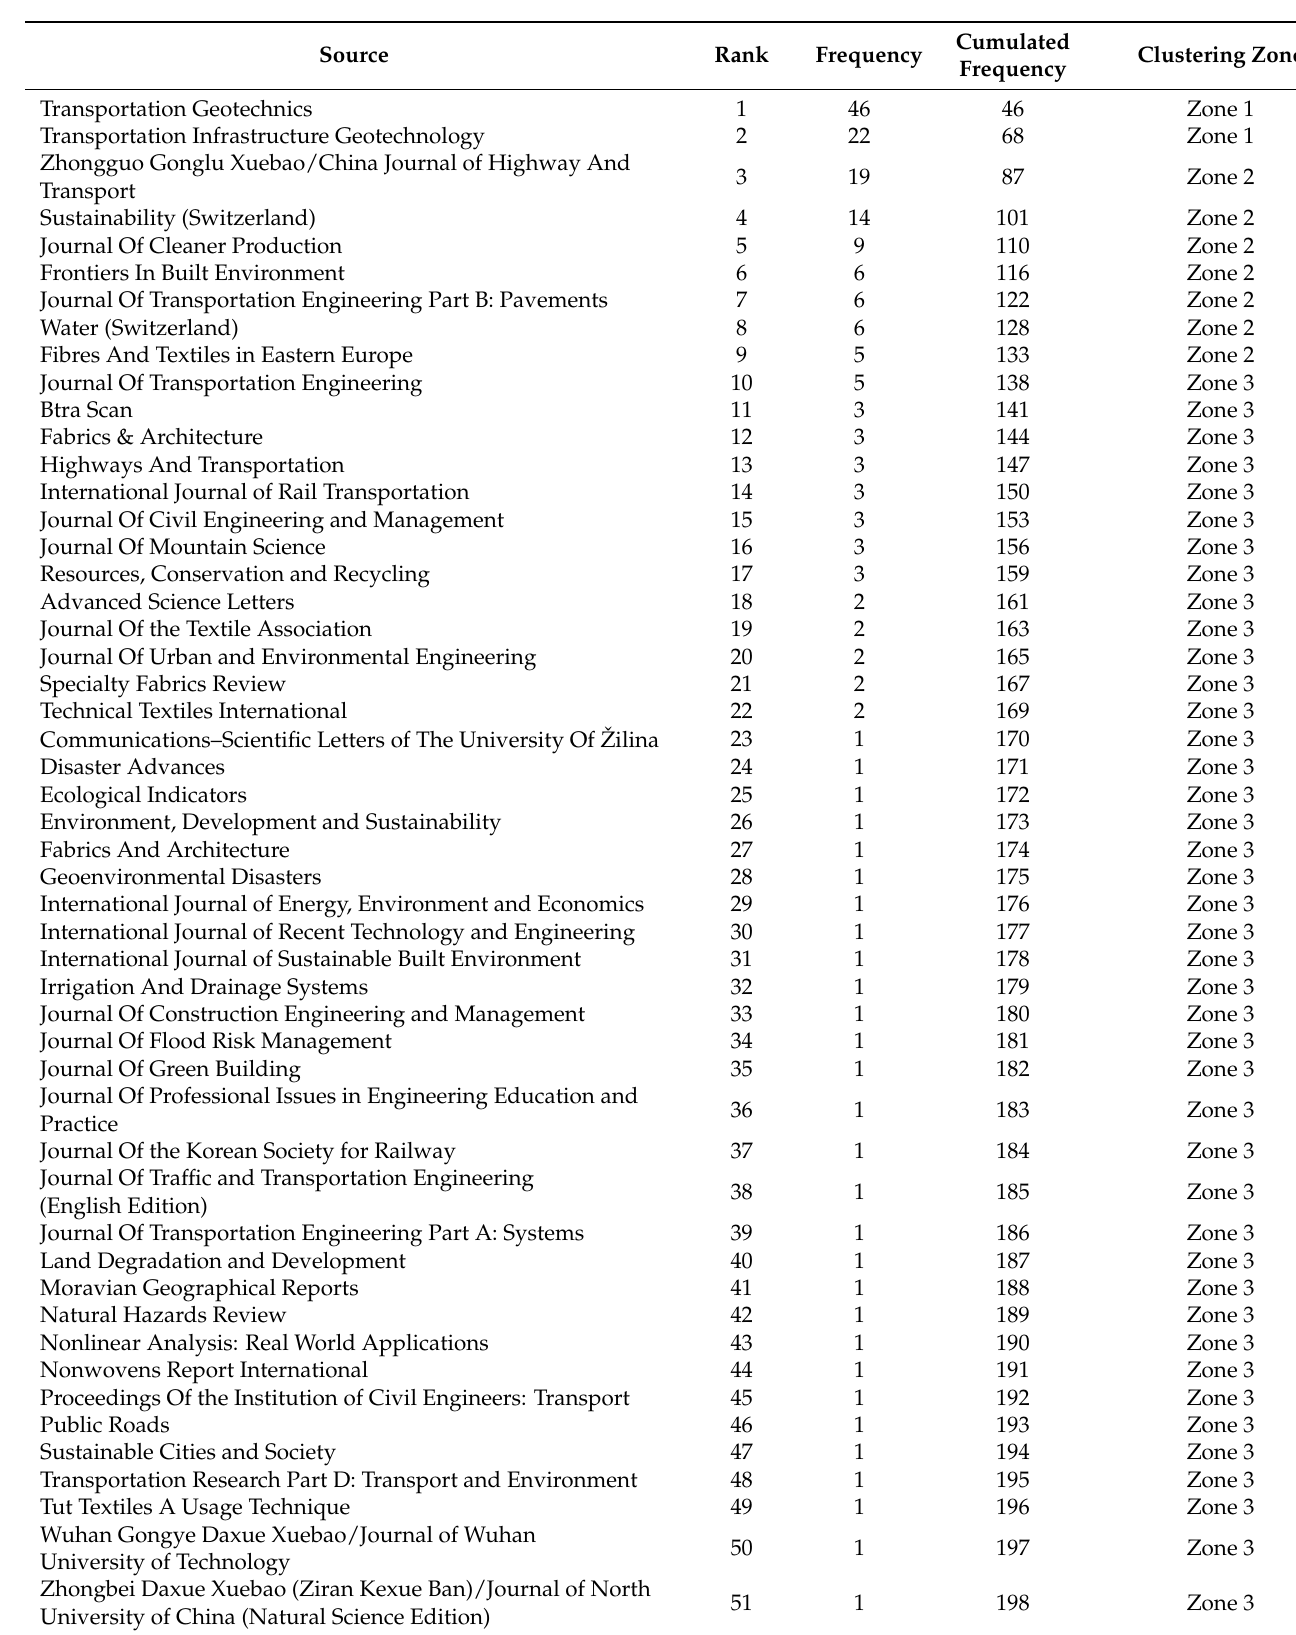
Table 9. Source clustering through Bradford’s